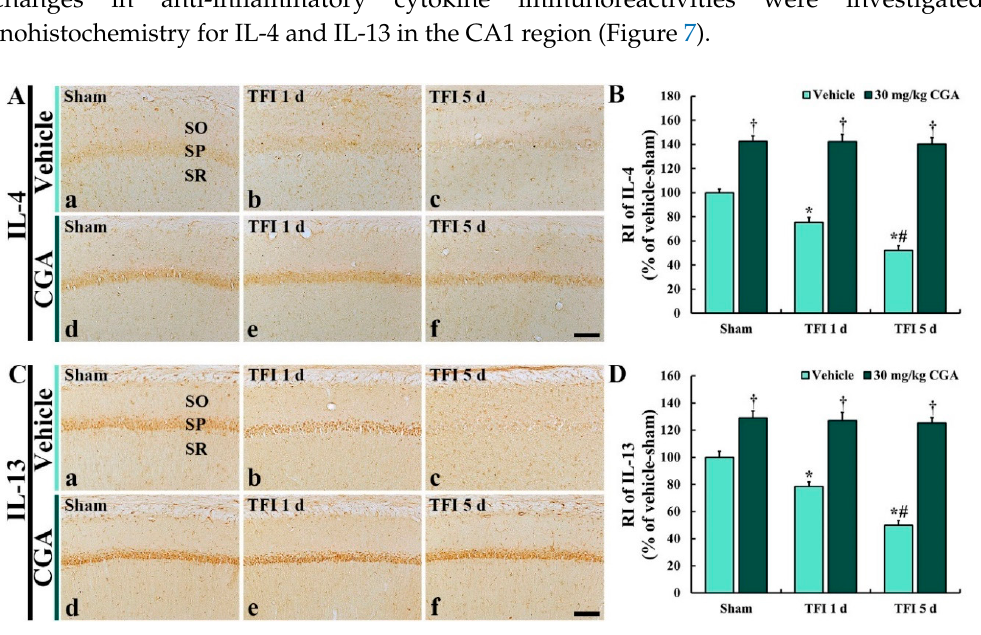
Figure 7. Immunohistochemistry for IL-4 ( A ) and IL-13 ( B ) of the vehicle/sham ( A ( a ), C ( a )), CGA/sham ( A ( d ), C ( d )), vehicle/TFI ( A ( b , c ), C ( c , d ) and CGA/TFI ( A ( e , f ), C ( e , f ) groups at 1 and 5 days after TFI.